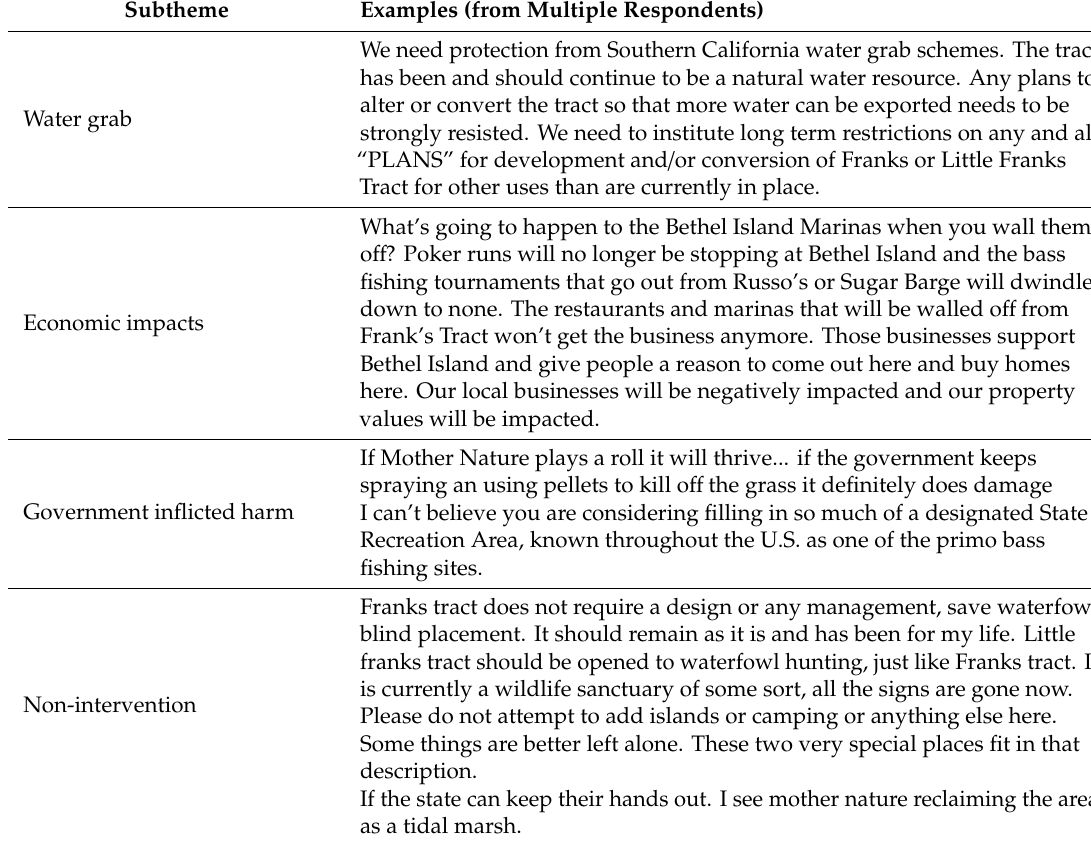
Table 1. Select sampling of state distrust / dissatisfaction survey responses.